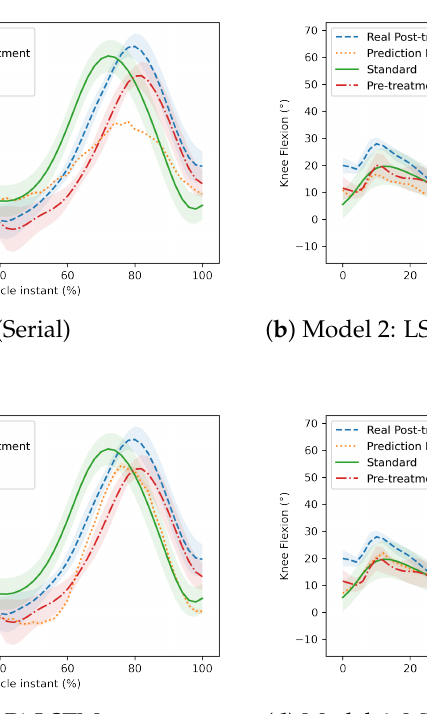
Figure 8. Comparison of the post-treatment gait trajectory of the knee and ankle joints in a patient diagnosed with CP. The first three models ( a – c ) are serial (Model 1, Model 2, and Model 3), and the fourth model ( d ) (Model 7) is an MTL model, which represents the prediction of the knee joint. The sixth and seventh models ( e , f ) are serial (Model 1 and Model 3), and the last two models ( g , h ) (Model 4 and Model 7) are MTL models, which represent the prediction of the ankle joint.